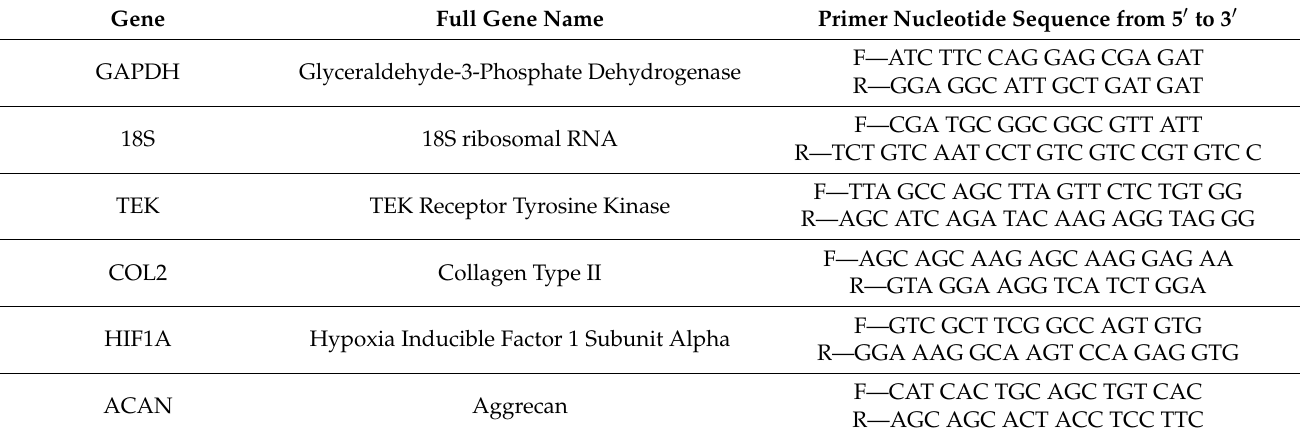
Table 2. Overview of human genes used for qPCR using glyceraldehyde-3-phosphate dehydrogenase ( GAPDH ) and 18S ribosomal RNA ( 18S ) as a reference gene. Genes analyzed for the NPCs: receptor tyrosine kinase ( TEK ), collagen type II ( COL2 ), hypoxia-inducible factor-1 α ( HIF1A ), aggrecan ( ACAN ). (F = forward, R =